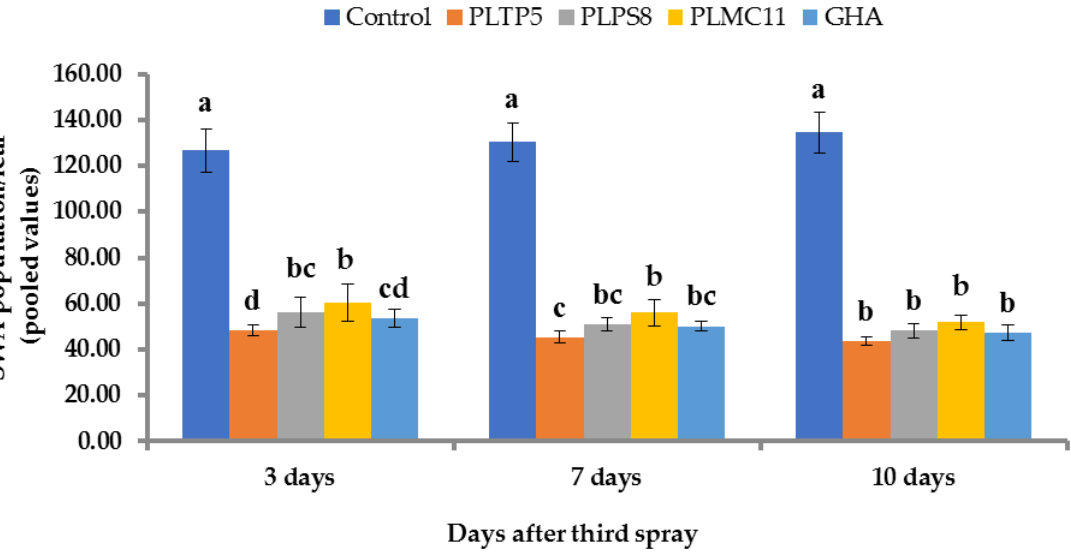
Figure 6. Population of C. lanigera per leave treated with 1 × 10 8 conidia mL − 1 of EPF isolates, recorded at different time intervals after third spray. Different letters (a–c) in columns indicate significant differences ( p ≤ 0.05) among the isolates. Columns represent the mean ± SD ( n = 3). SD = standard deviation.